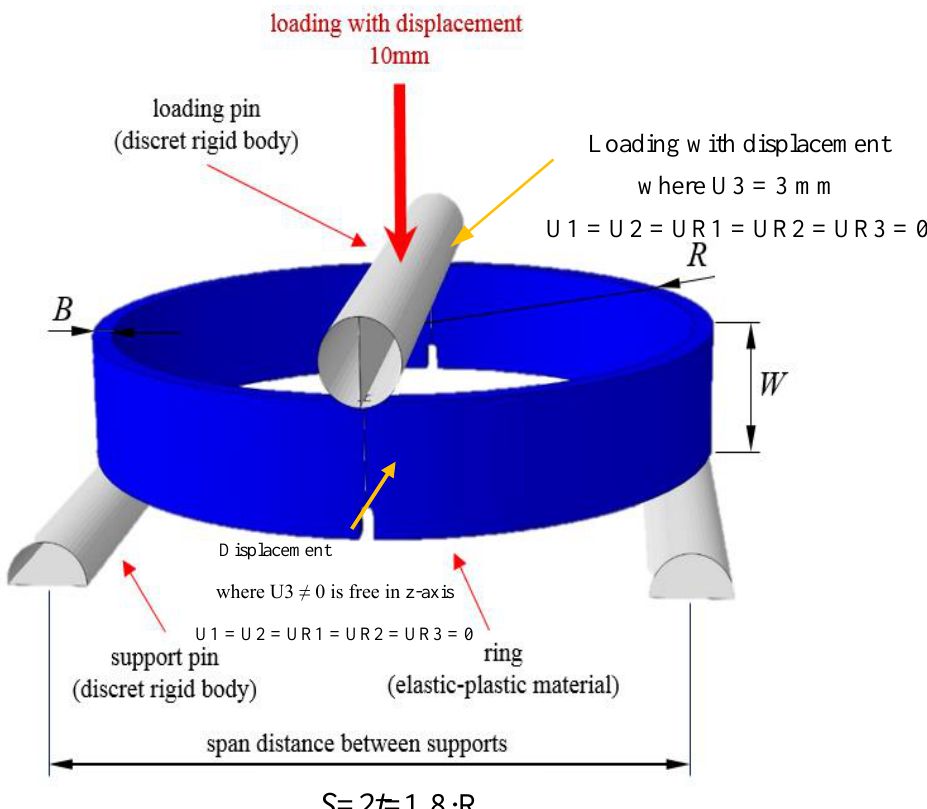
Figure 3. Schematically shown geometry of the ring R / B = 20, B = 4 mm, W = 8 mm, the span distance between the supports for FEA. The loading mode is three point bending, the scale of the sketch and the dimension do not correspond to the actual ring size).